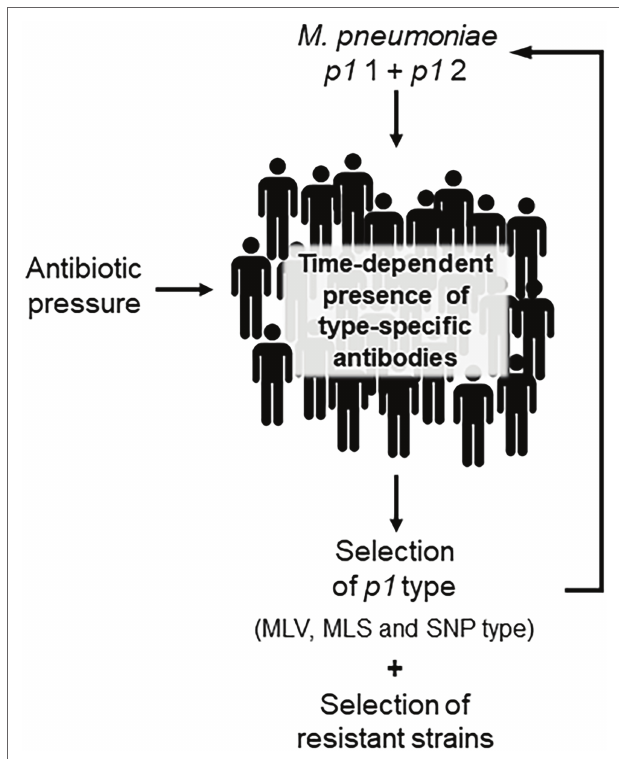
FIGURE 2 | Schematic illustration of time-dependent shift of Mycoplasma pneumoniae